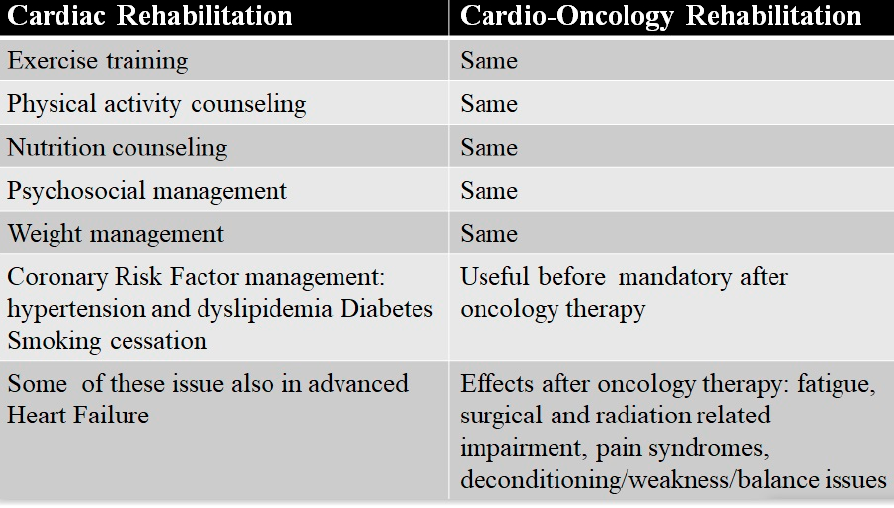
Figure 2. Core components of cardiac and Cardio-Oncology Rehabilitation programs.